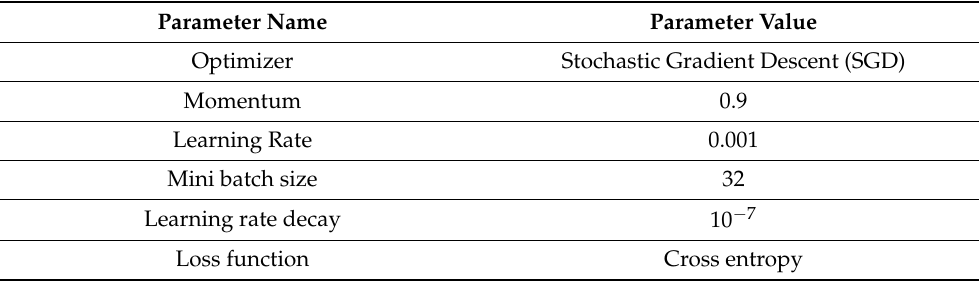
Table 2. Summary of hyperparameters for ArrhythmiaNet training.